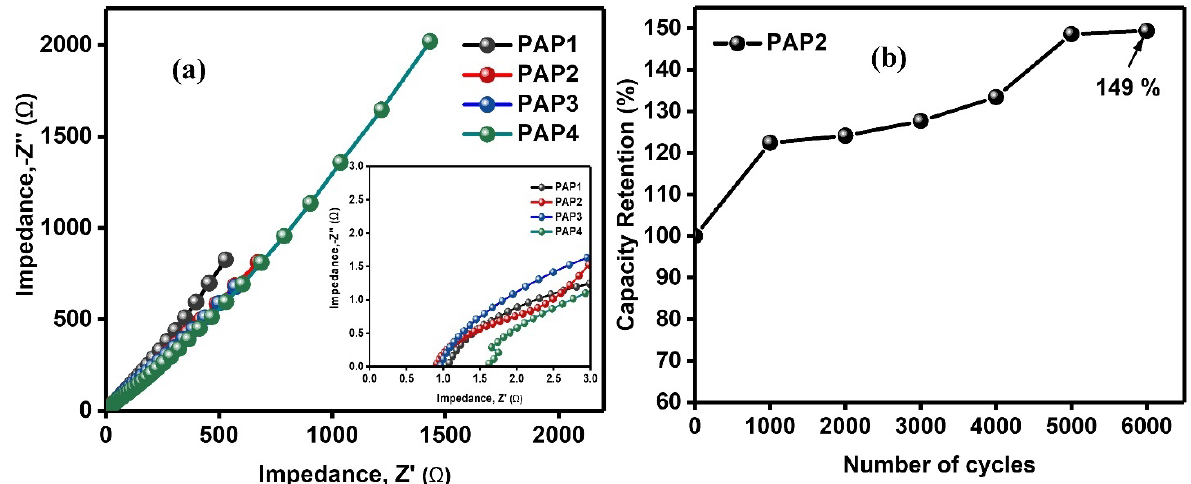
Figure 14. ( a ) Nyquist plots of all supercapacitors and ( b ) Cyclic stability of PAP2 all-in-one flexible supercapacitor (inset in figure demonstrate the Nyquist plot).